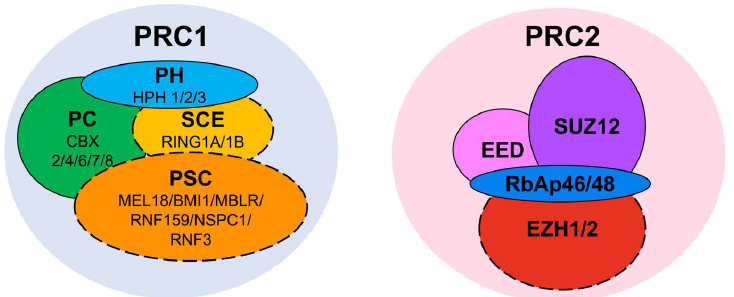
Figure 1. Major components of PRC1 and PRC2. Compositions of the two major types of the Polycomb repressive complexes. Mammalian PcG repressive complex 1 (PRC1) comprises interchangeable paralogs for the four main subunits: three of Polyhomeotic (PH), five of Polycomb (PC), two of Sex Comb Extra (SCE), and six of Posterior Sex Comb (PSC). Together, the SCE and PSC subunits contain the E3 ubiquitin ligase catalytic activity of PRC1 (dotted boundary). Human PcG repressive complex 2 (PRC2) consists of the core subunits EZH1/2, SUZ12, EED and RbAp46/48, with EZH1/2 (dotted boundary) possessing the methyltransferase catalytic activity of PRC2.